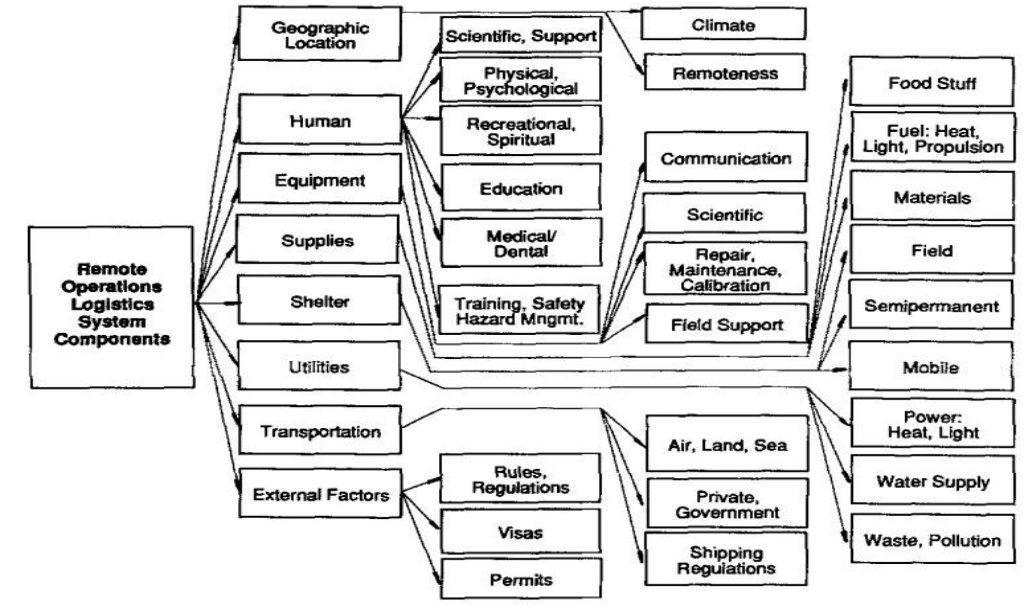
Figure 6: Remote Operations Logistics Systems Components